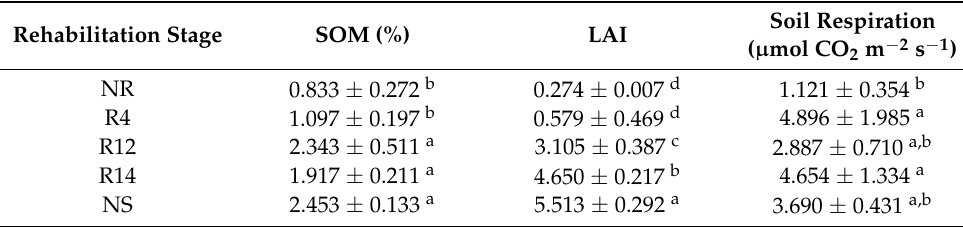
Table 3. Mean and standard deviation of environmental variables analyzed in this work for each rehabilitation stage. Means followed by the same letter did not differ significantly in the Tukey test ( p < 0.05).